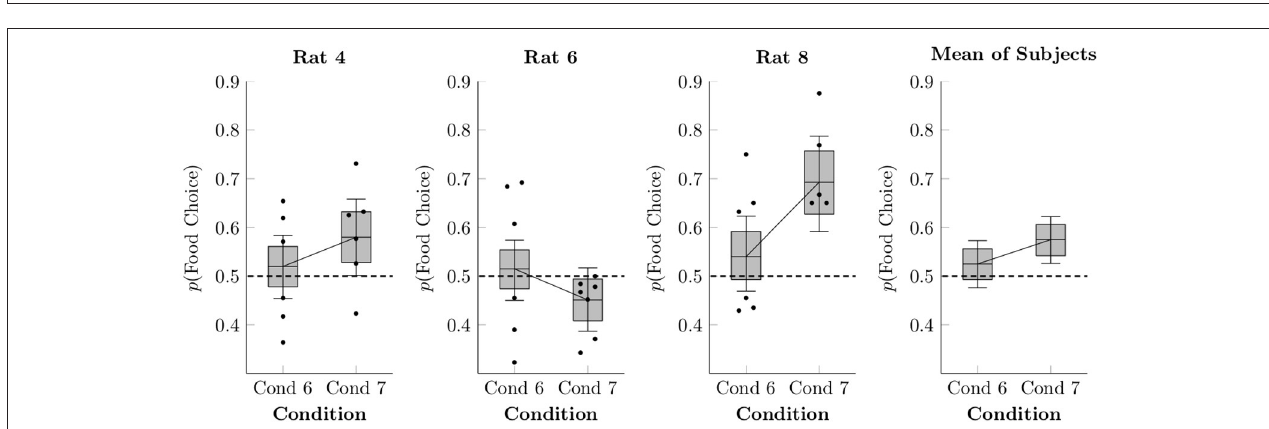
FIGURE 4 | Estimated number of pellets consumed by the focal rat (black circles) and shared with the restrained rat (white diamonds) in Conditions 1–4 based on a multi-level negative binomial regression, as well as observed counts. Points represent number of pellets in each category per session, whereas boxes represent the 80% credible interval and whiskers represent the 95% credible interval of the estimated rate.